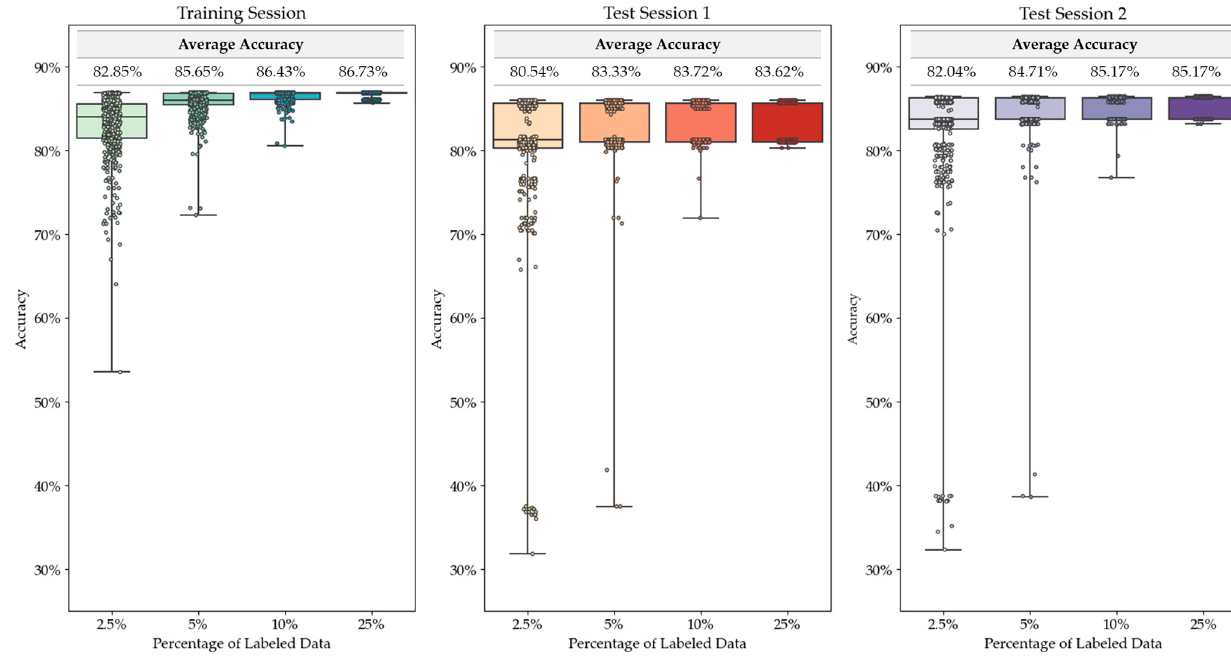
Figure 5. Semi-supervised self-training results across 500 trials.